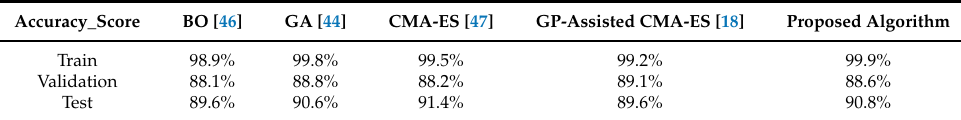
Table 3. Simulated results of all experimental algorithms with 2000 spiking neurons on MINIST.